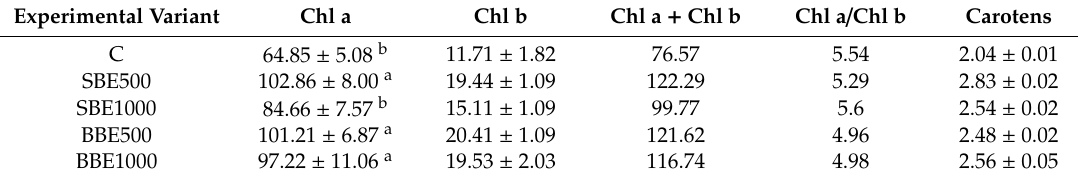
Table 2. Content of photo-assimilating pigments synthesized ( µ g / g) in lavender leaves. Experimental Variant